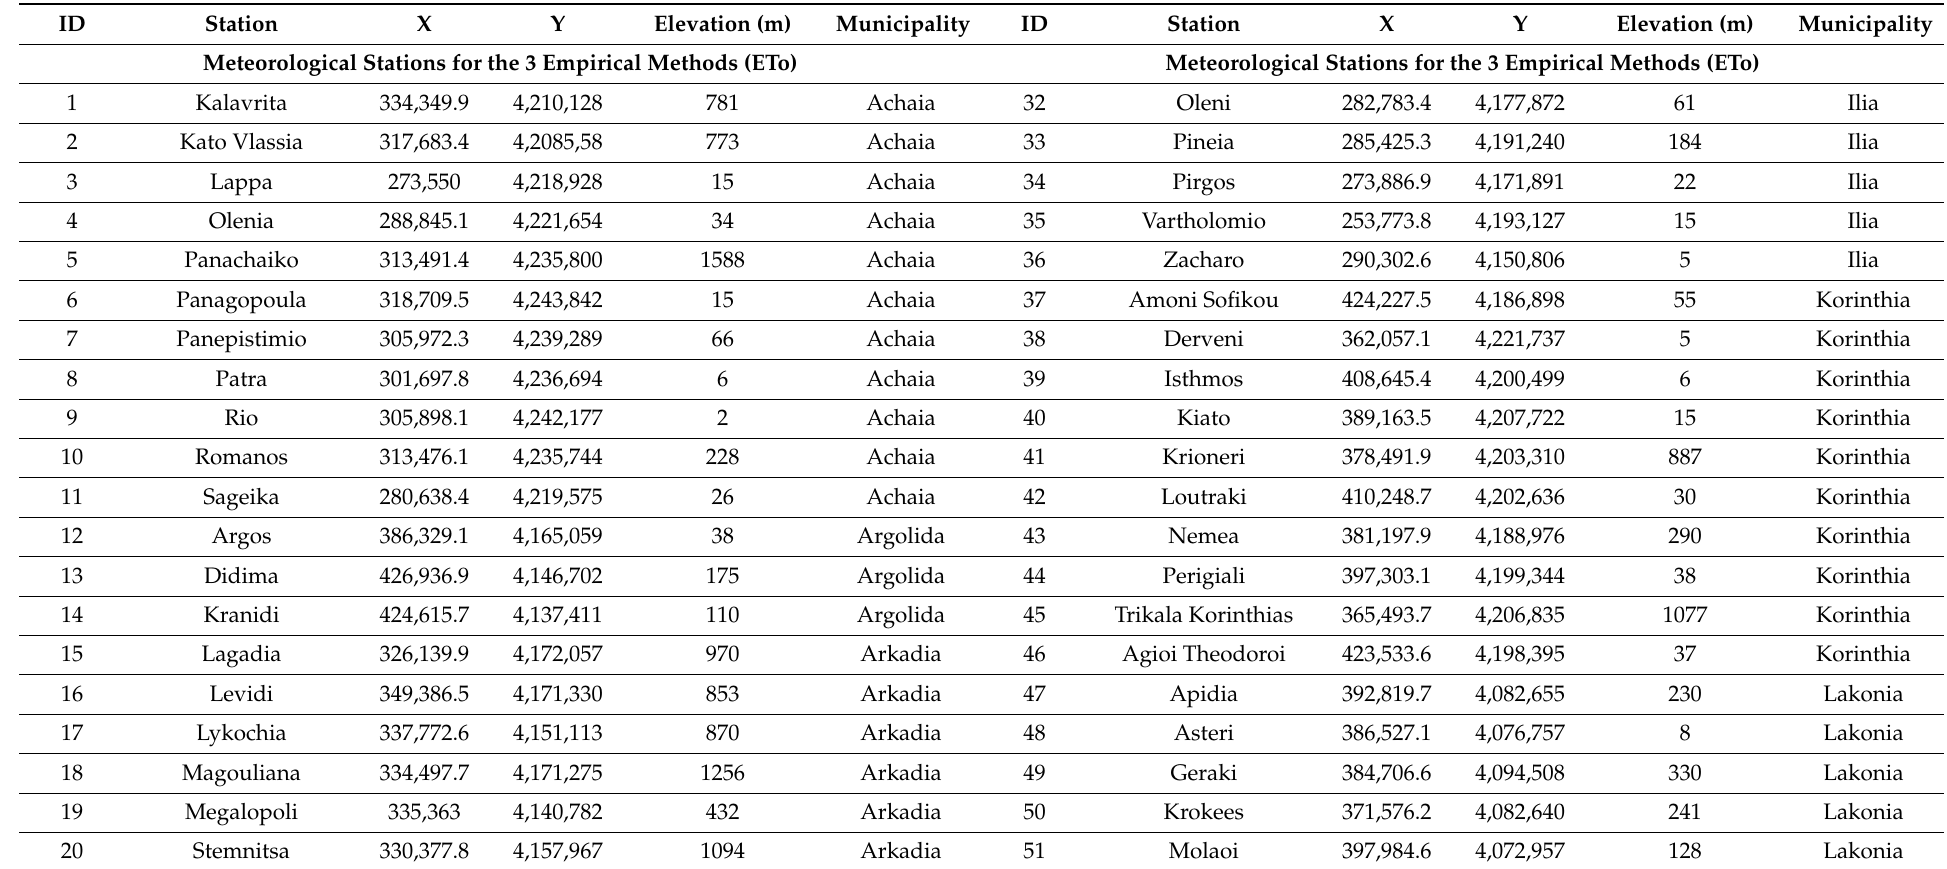
Table A1. Meteorological stations (62) used (source: https://meteosearch.meteo.gr (accessed on 15 April